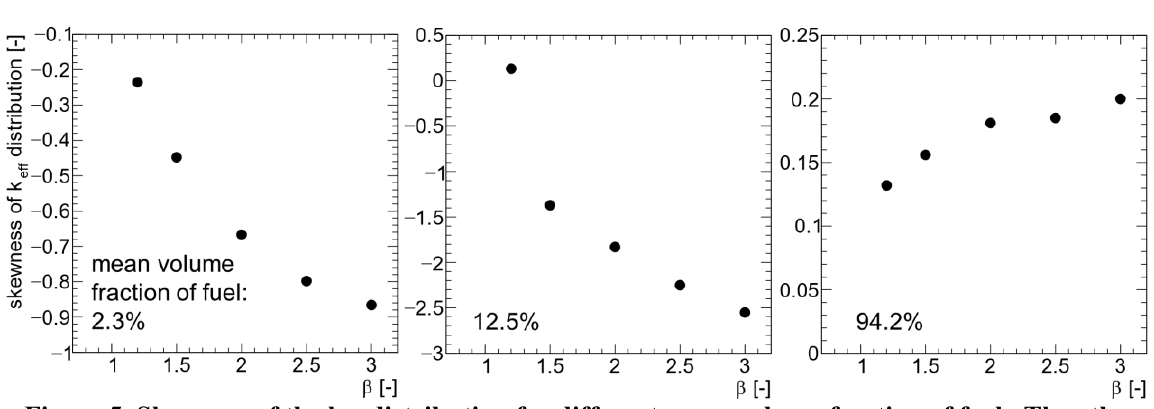
distribution for different mean volume fraction of fuel. The other Figure 5. Skewness of the k eff meanings of figures are the same as Figure 4.